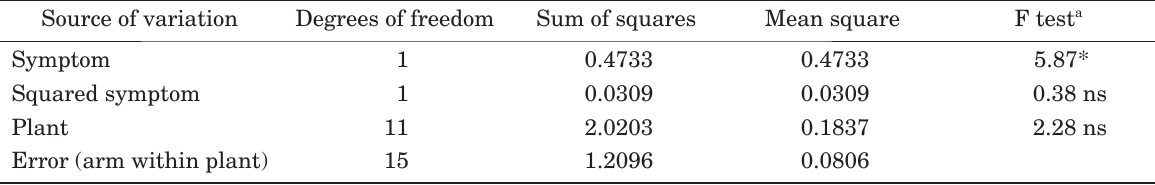
a ns, not signi fi cant; *, 0.05> P >0.01; **, 0.01> P >0.001; ***, 0.001> P >0.0001.